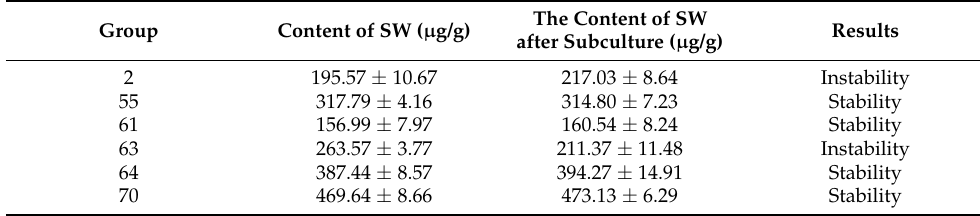
Table 7. Results of stability test for SW production of mutant strains.